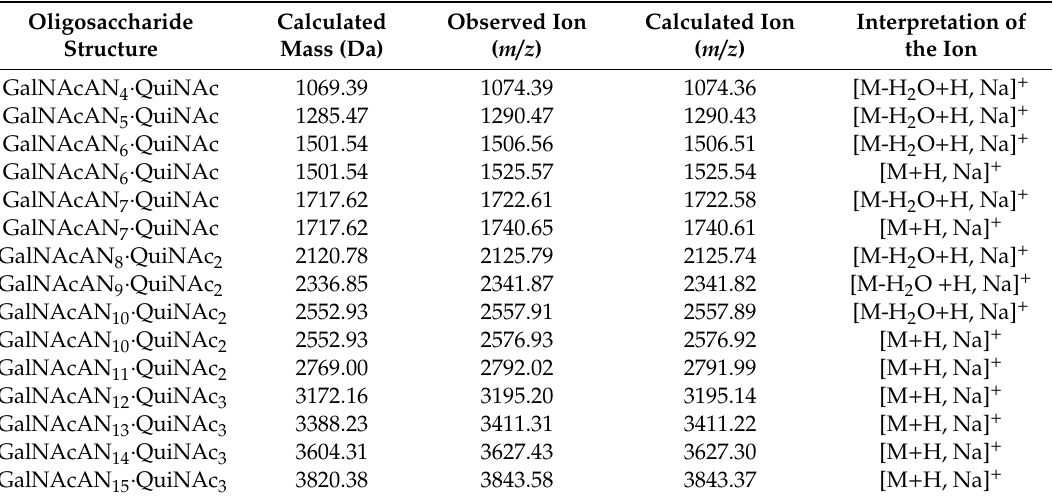
GalNAcAN 13 · QuiNAc